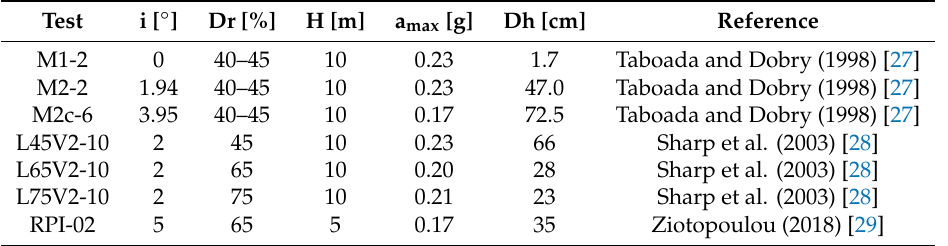
Table 2. Centrifuge tests used to validate the numerical